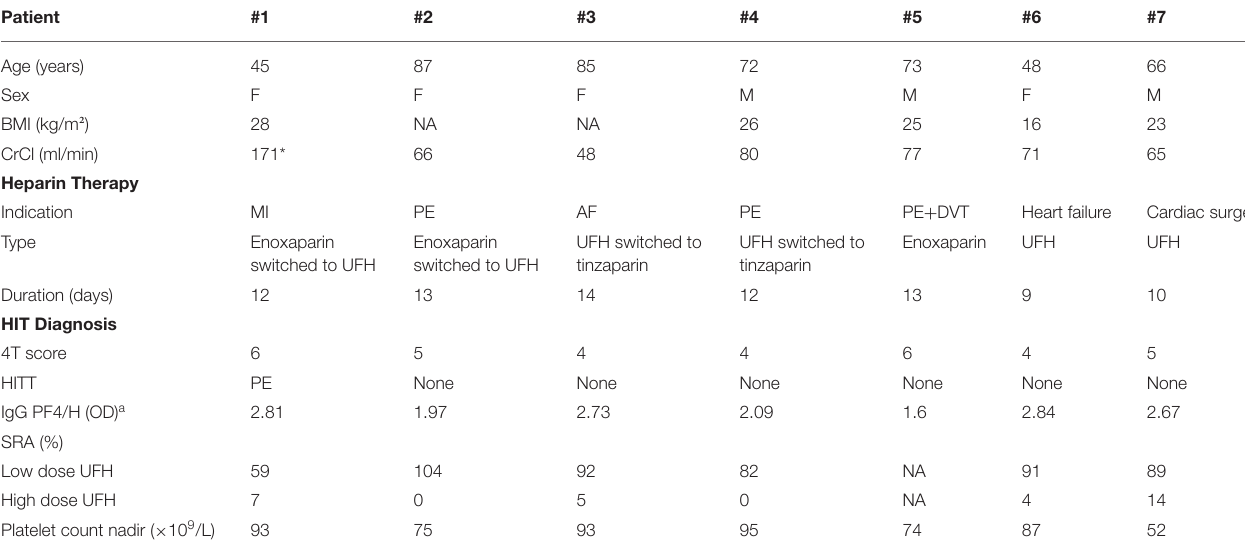
TABLE 1 | Characteristics of HIT-suspected patients treated by DOACs.